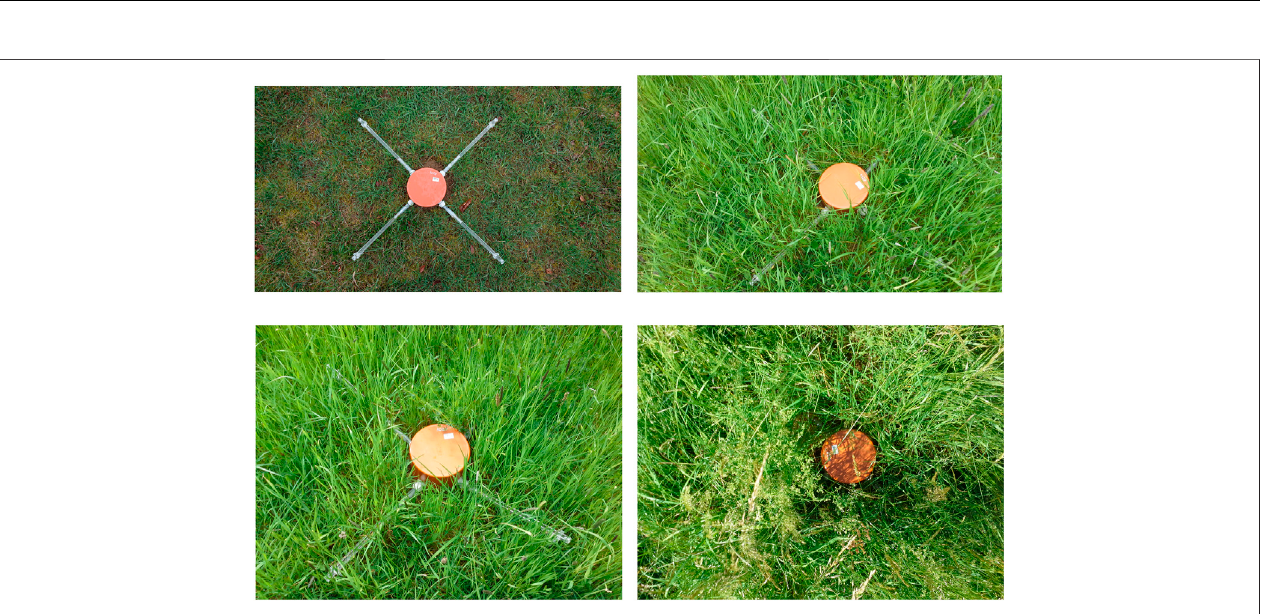
FIGURE 4 | Example of one interception tube (upper left) uncovered period, and the same measurement location during the covered period (upper right) at 07.05.2019, (lower left) at 15.05.2019 and (lower right) at 13.06.2019.